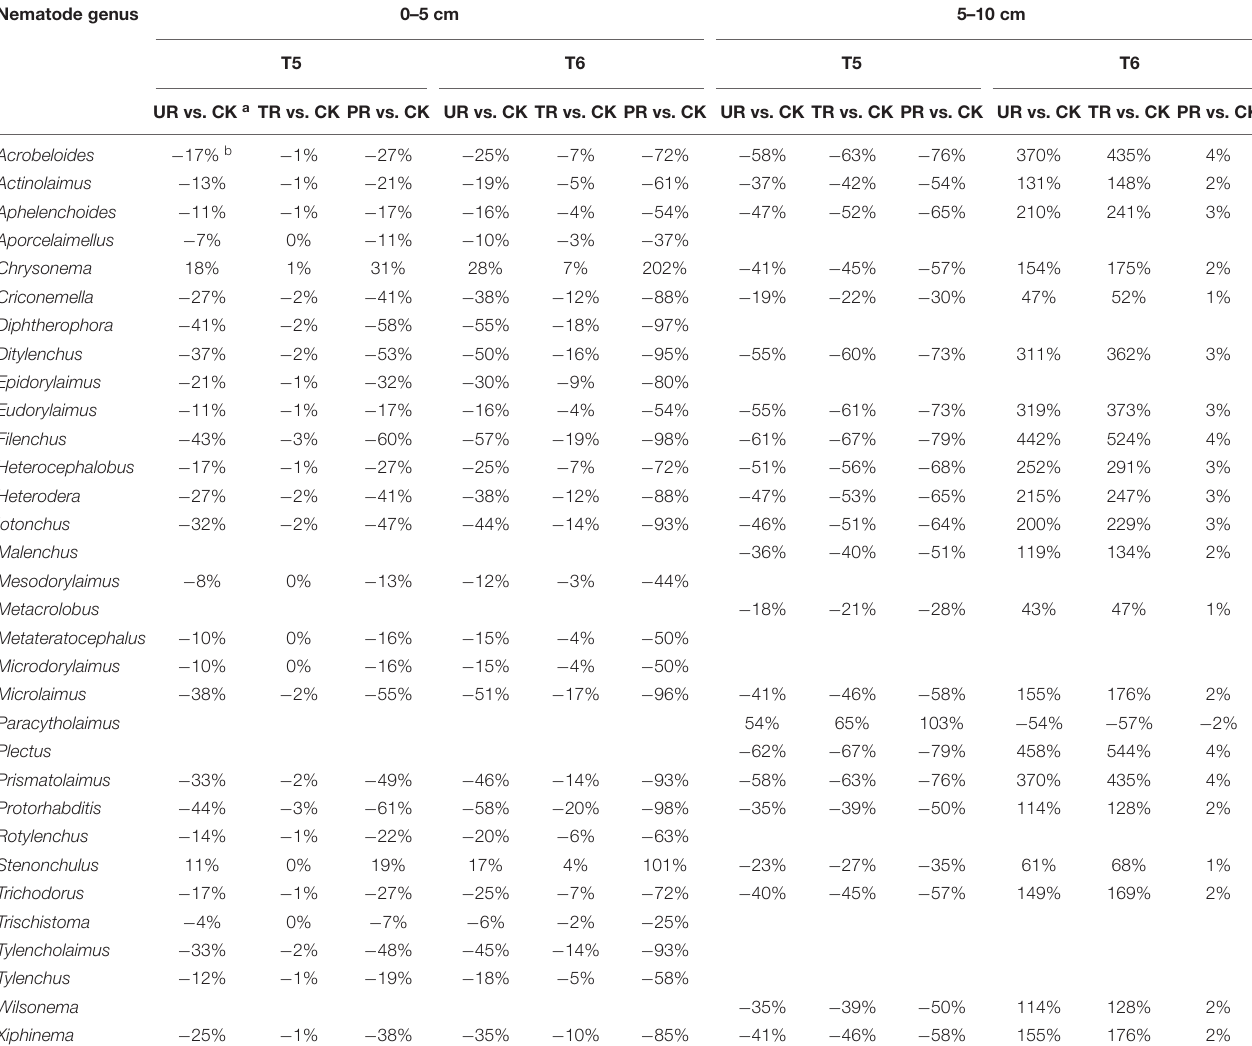
TABLE 1 | The relative deviation of nematode genera under vegetation removal treatments from the control at the fifth (T5) and sixth (T6) sampling events at the 0–5 cm and 5–10 cm soil depths. Nematode